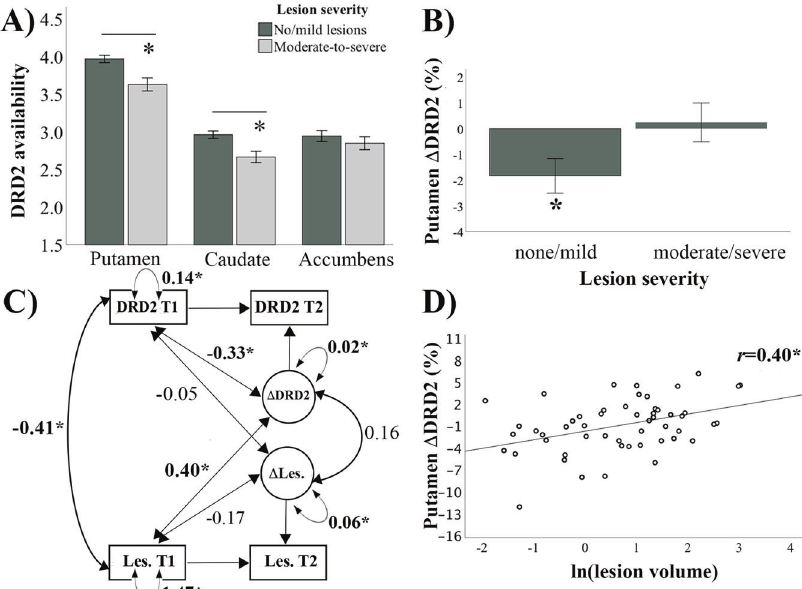
Fig. 2 Lesion severity and putamen DRD2 availability. The group with elevated lesion severity displayed reduced DRD2 availability in putamen and caudate at baseline A , and lack of signi fi cant intervention-related DRD2 change for putamen B . Linear relationships were found between baseline lesion volume and baseline DRD2 levels, as well as for baseline lesion volume and the degree of DRD2 change C , D . * p < 0.05. DRD2 dopamine D2-receptor, T1 timepoint 1 - baseline, T2 timepoint 2 - follow-up, Les. lesions, Δ